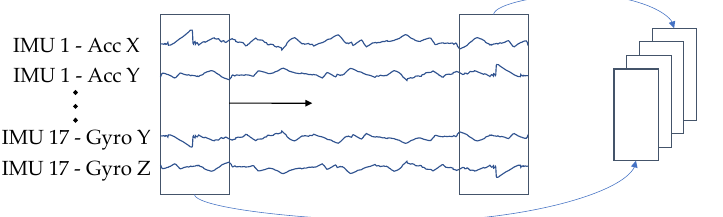
Figure 4. Input representation for the proposed neural network. The individual sensor channels are combined line by line so that they result in an image-like representation.